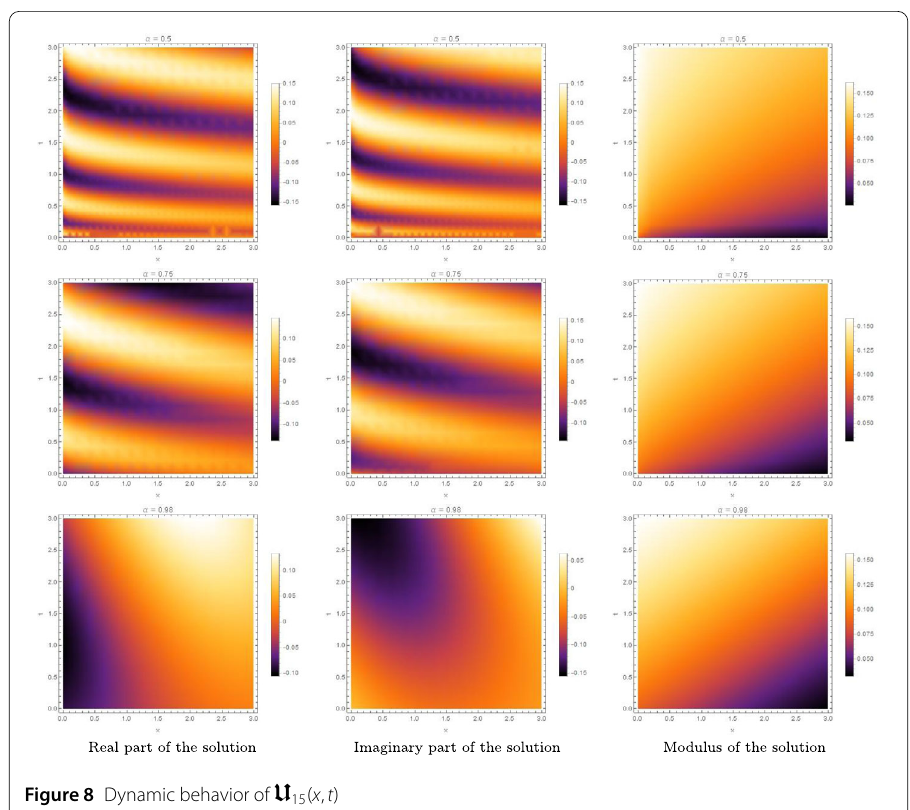
Figure 8 Dynamic behavior of U 15 ( x , t )